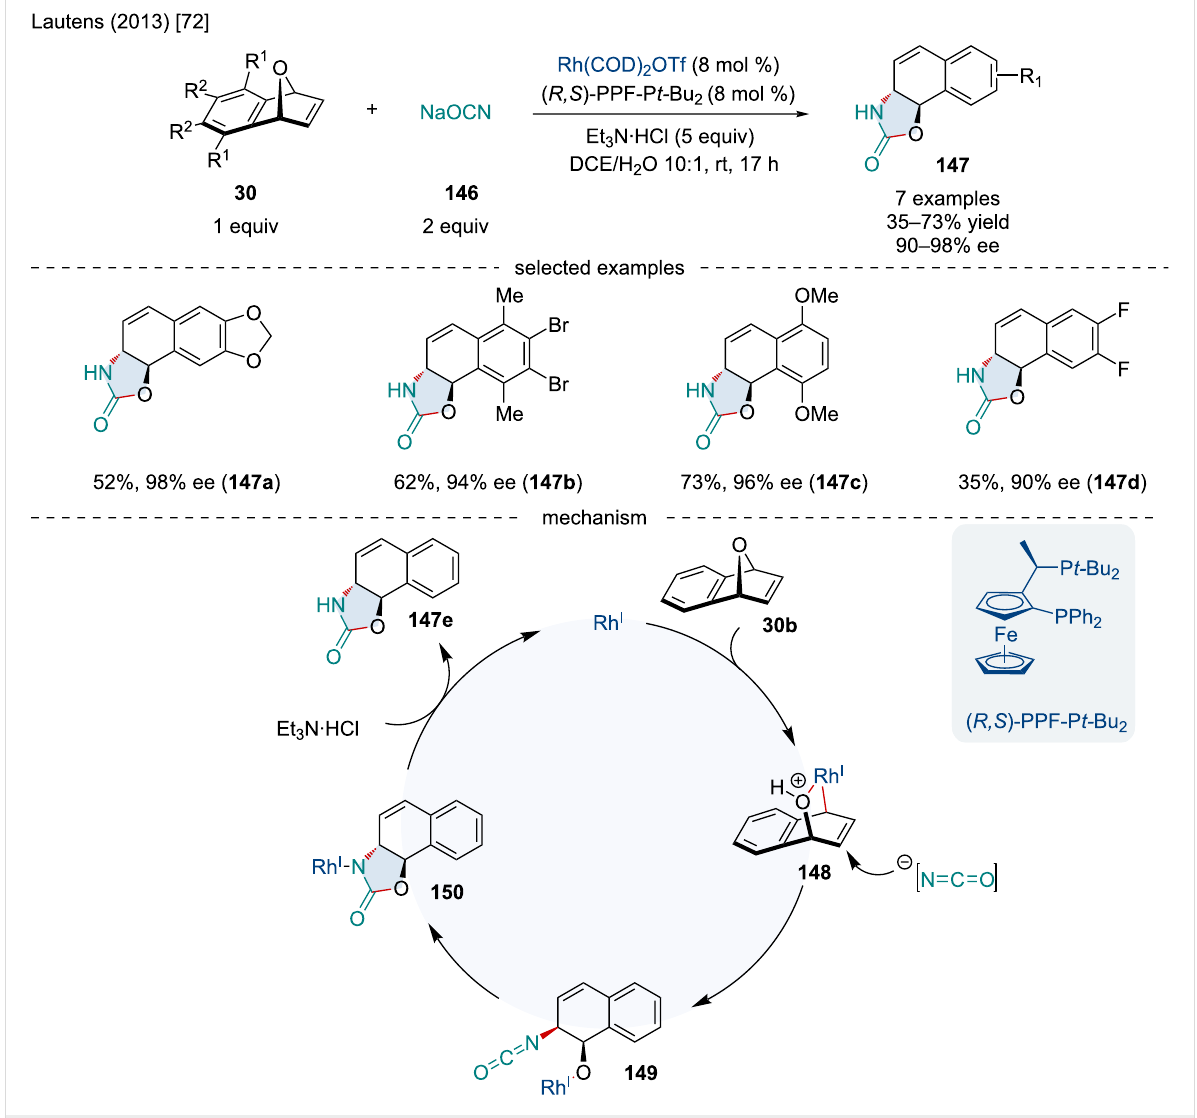
Scheme 26: Rh-catalyzed synthesis of oxazolidinone scaffolds 147 through a domino ARO/cyclization of oxabicyclic alkenes 30 with sodium cyanate ( 146